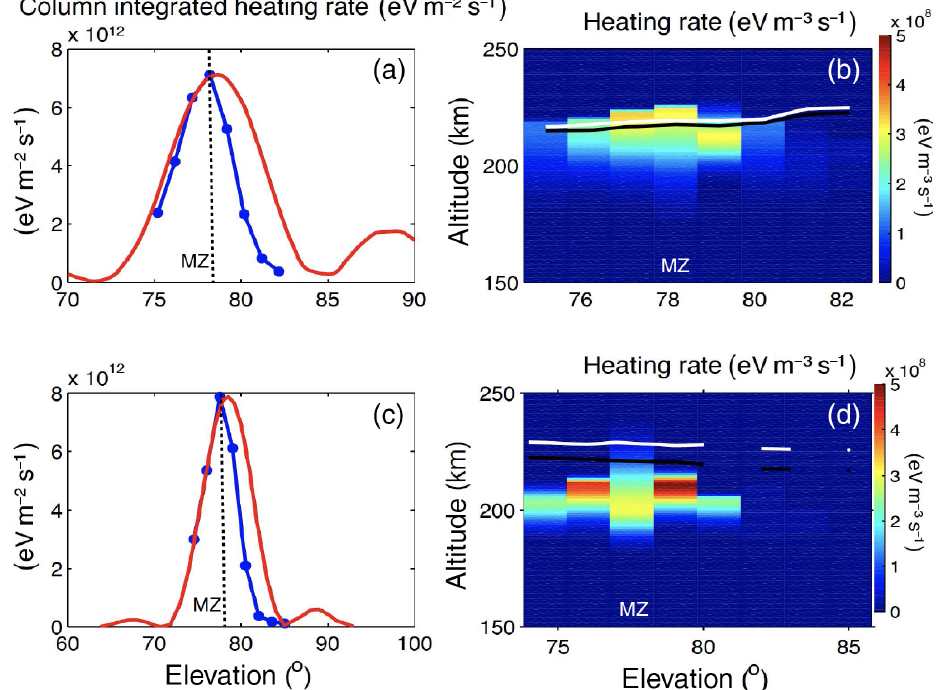
Figure 6. Modelled electron heating rate Q HF (eVm − 3 s − 1 ) during steady state versus radar elevation angle for 25 November 2014 (a, b) and 24 October 2017 (c, d) . Panels a and c display the column-integrated Q HF (blue dots, with connecting lines to guide the eye) and the relative intensity of the transmitted Heating beam (red) assumed to propagate in vacuum. The elevation corresponding to magnetic zenith is indicated by the dashed line and labelled MZ. Panels b and d show the altitude profiles of Q HF . The white line indicates the altitude of the plasma resonance where f p = f 0 and the black line shows the upper hybrid resonance height at which the upper hybrid frequency equals f 0 . Note that the elevation scale is different in panels a and b and c and d